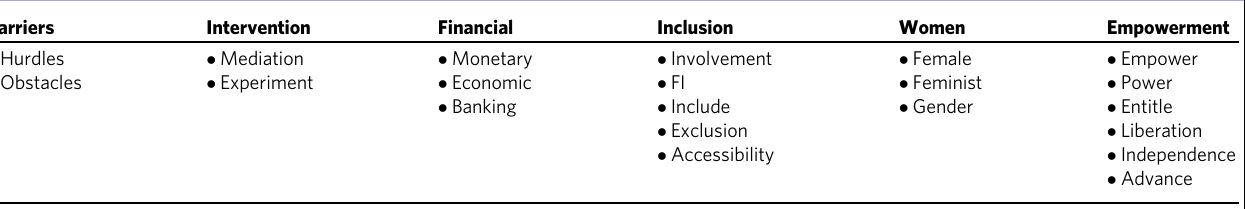
Table 1 Keywords.